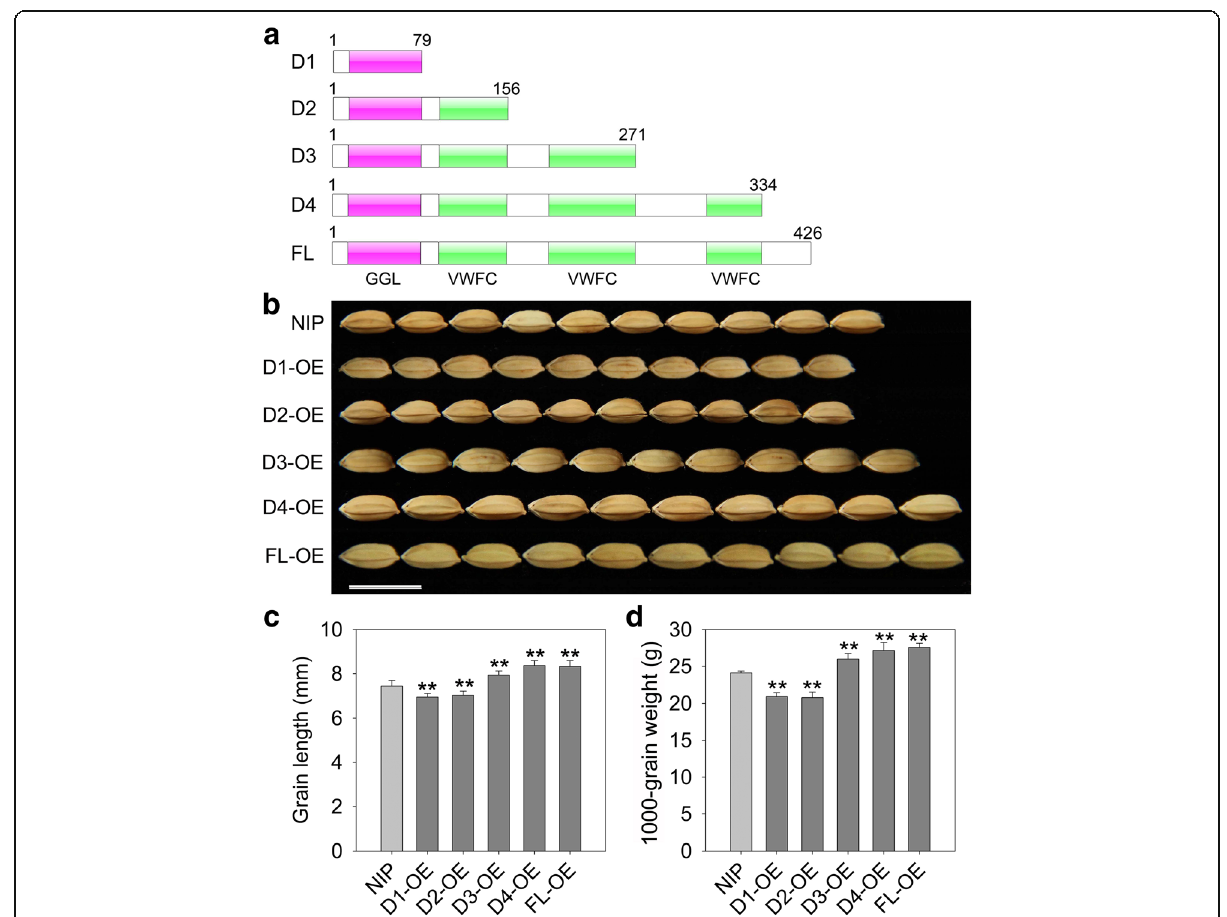
Fig. 3 Overexpression of different domains of qPE9 – 1 generated grains of different lengths and weights. a Several constructs covering different domains of qPE9 – 1. D1 contained the GGL domain and lacked three VWFC domains. D2, D3, and D4 contained the GGL domain and